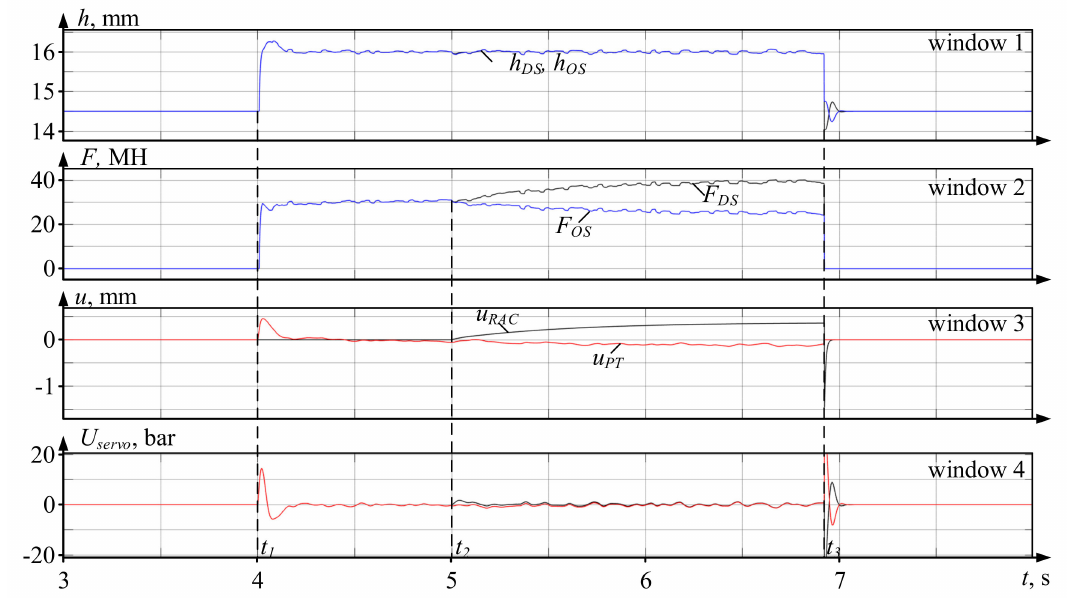
Figure 11. Simulation of roll gap misalignment with the proposed solutions: Panel 1 shows side-specific gauge, mm; Panel 2 shows rolling forces for DS and OS, MN; Panel 3 shows the controller outputs, mm; Panel 4 shows signals to the SD servo valves,